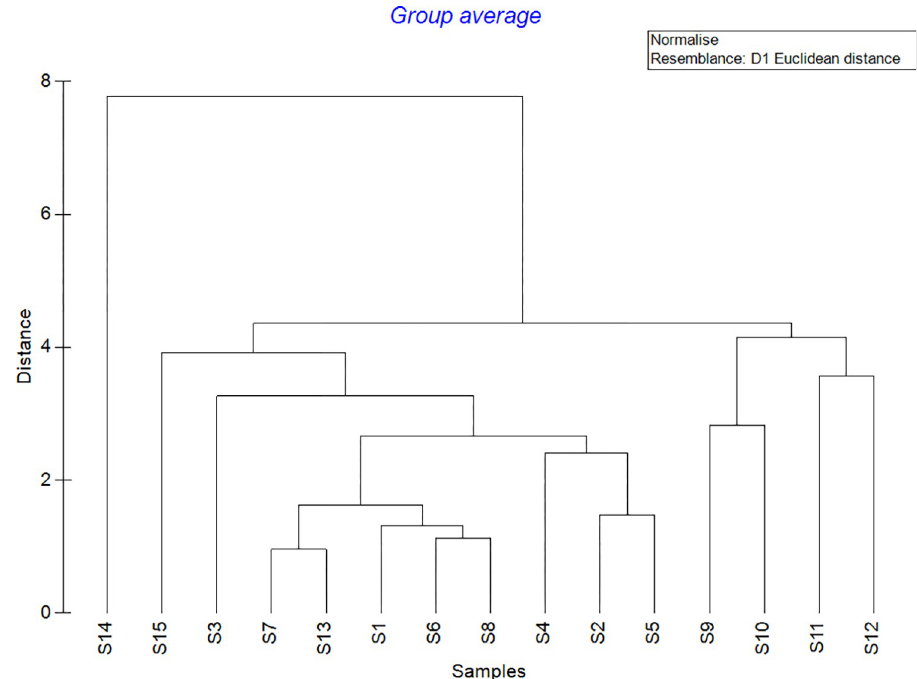
Fig 4. CLUSTER analysis showed the similarity of environmental parameters between